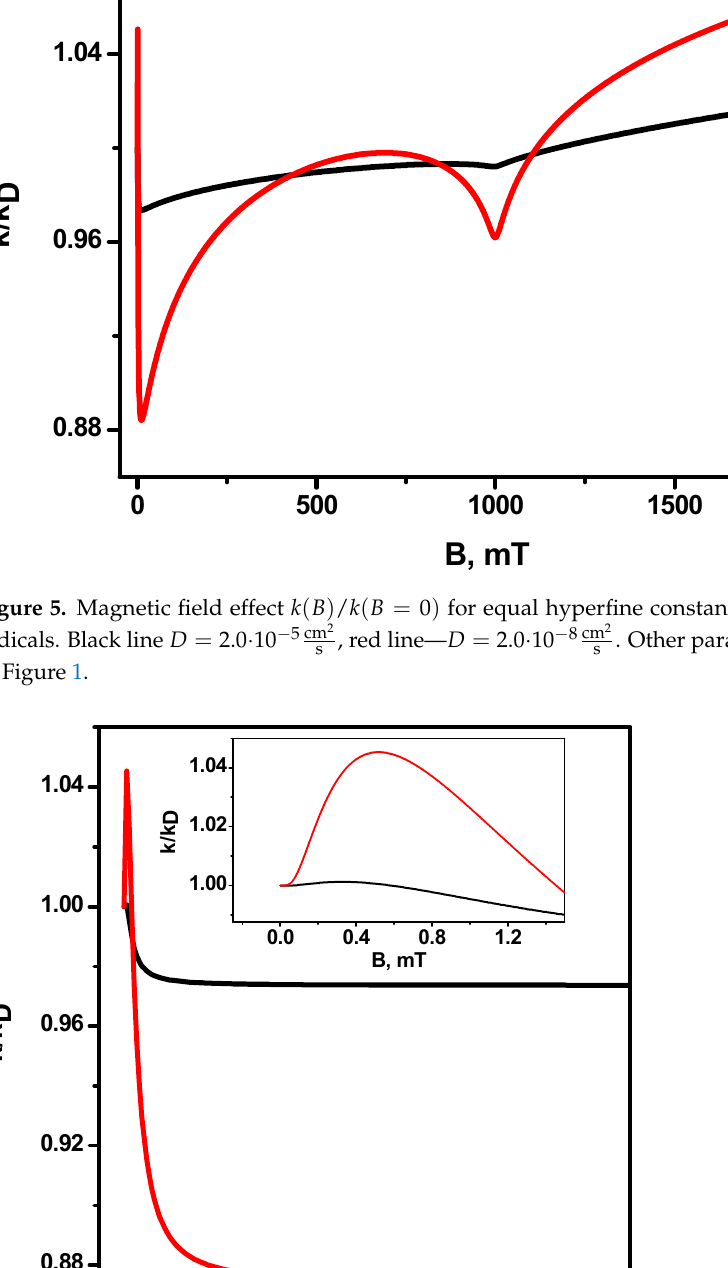
(cid:3118) . Other parameters . Other param- s (cid:2929)